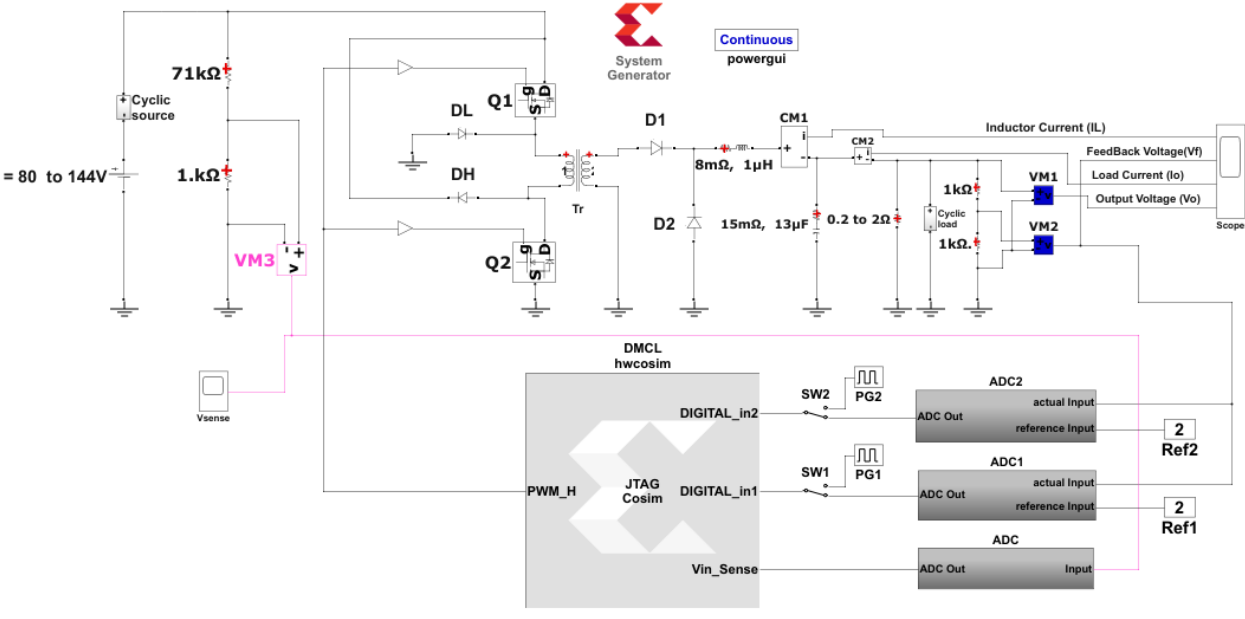
Figure 16. Hardware co-simulation setup.